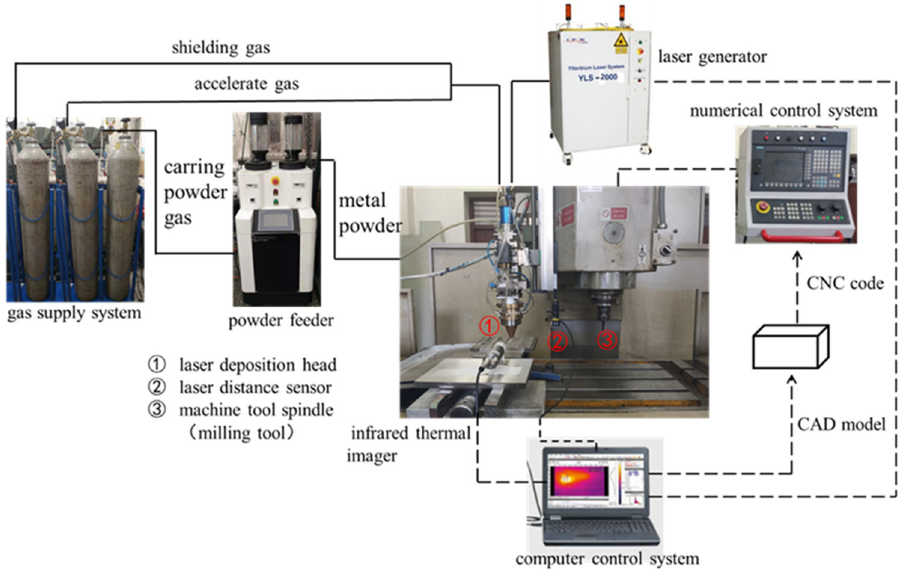
Figure 2. Experimental system of laser cladding additive and subtractive hybrid manufacturing.